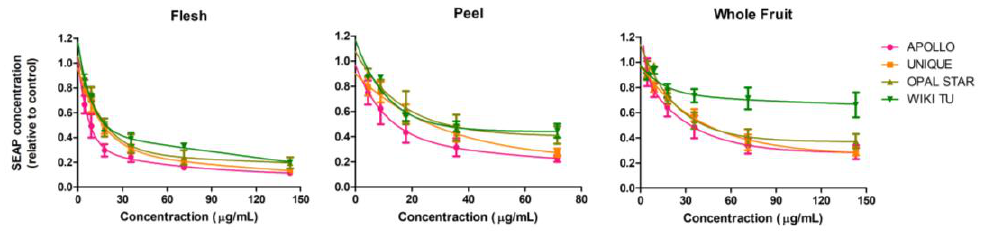
Figure 1. Anti-inflammatory activity in the HEK-Blue™ hTLR2 cell line. Cells were treated with feijoa flesh, peel and whole fruit extracts from APOLLO, UNIQUE, OPAL STAR and WIKI TU cultivars. PAM3CSK4 ligand was used to stimulate an inflammatory response through the TLR2 pathway. Secreted embryonic alkaline phosphatase (SEAP) concentration was normalized against solvent control. A low SEAP concentration indicates a strong anti-inflammatory effect.